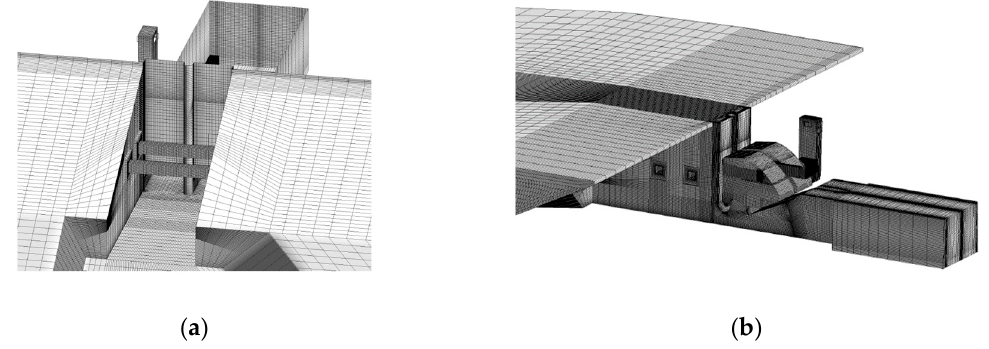
Figure 5. Numerical grid for discharge from two outlets (Case 1). The cell number is 950,000. ( a ) Upstream view; ( b ) side view.